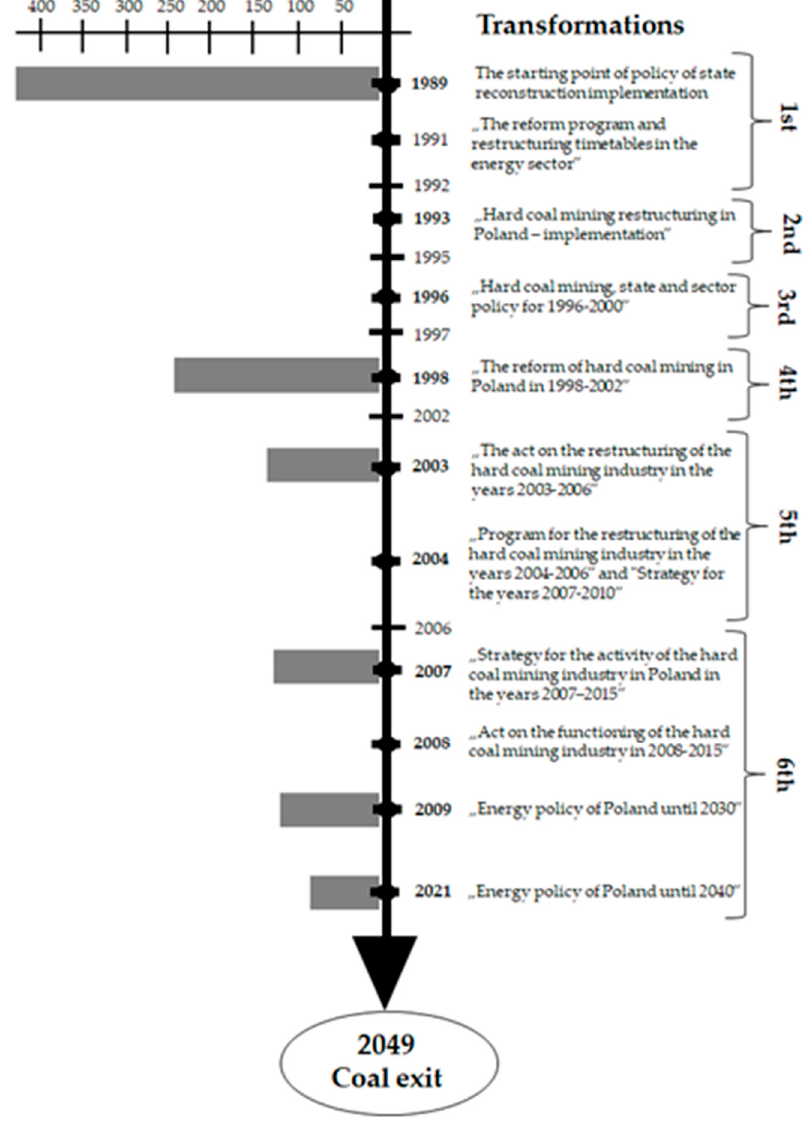
Figure 4. The relationship between national energy policy and employment rate.